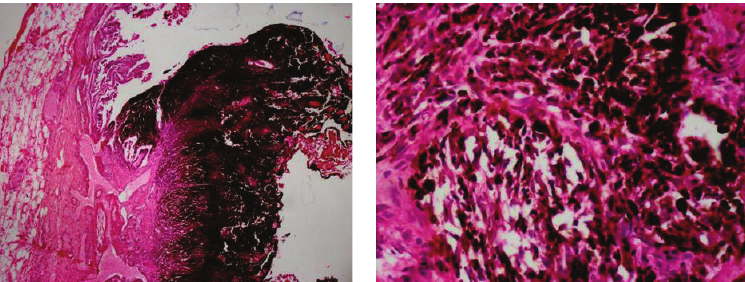
Figure 2: Malign epithelial tumor consisting of atypical cells with large eosinophilic cytoplasm, vesicular nucleus, and prominent nucleolus, which showed infiltration nesting beneath the epithelium of the gallbladder. A dense melanin pigment within the cytoplasm of the tumor cells was also